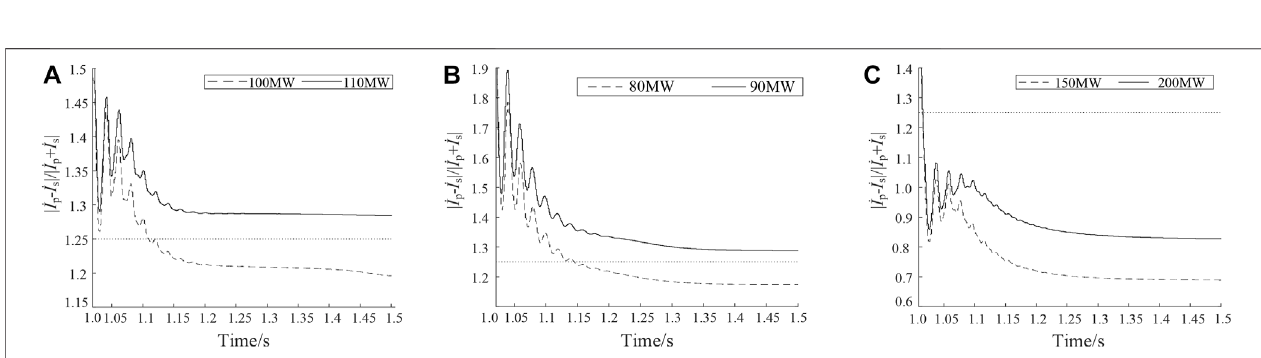
FIGURE 3 | Ratio of restraint- and differential-current under various fault: (A) phase A-GND fault, (B) phase A-B fault, and (C) phase A-B-GND